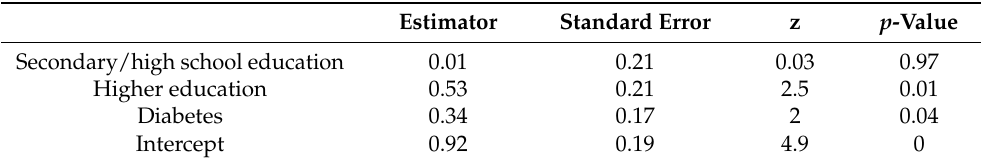
Table 2. Question four—logistic regression model; two or more responses indicating the satisfactory level of knowledge.